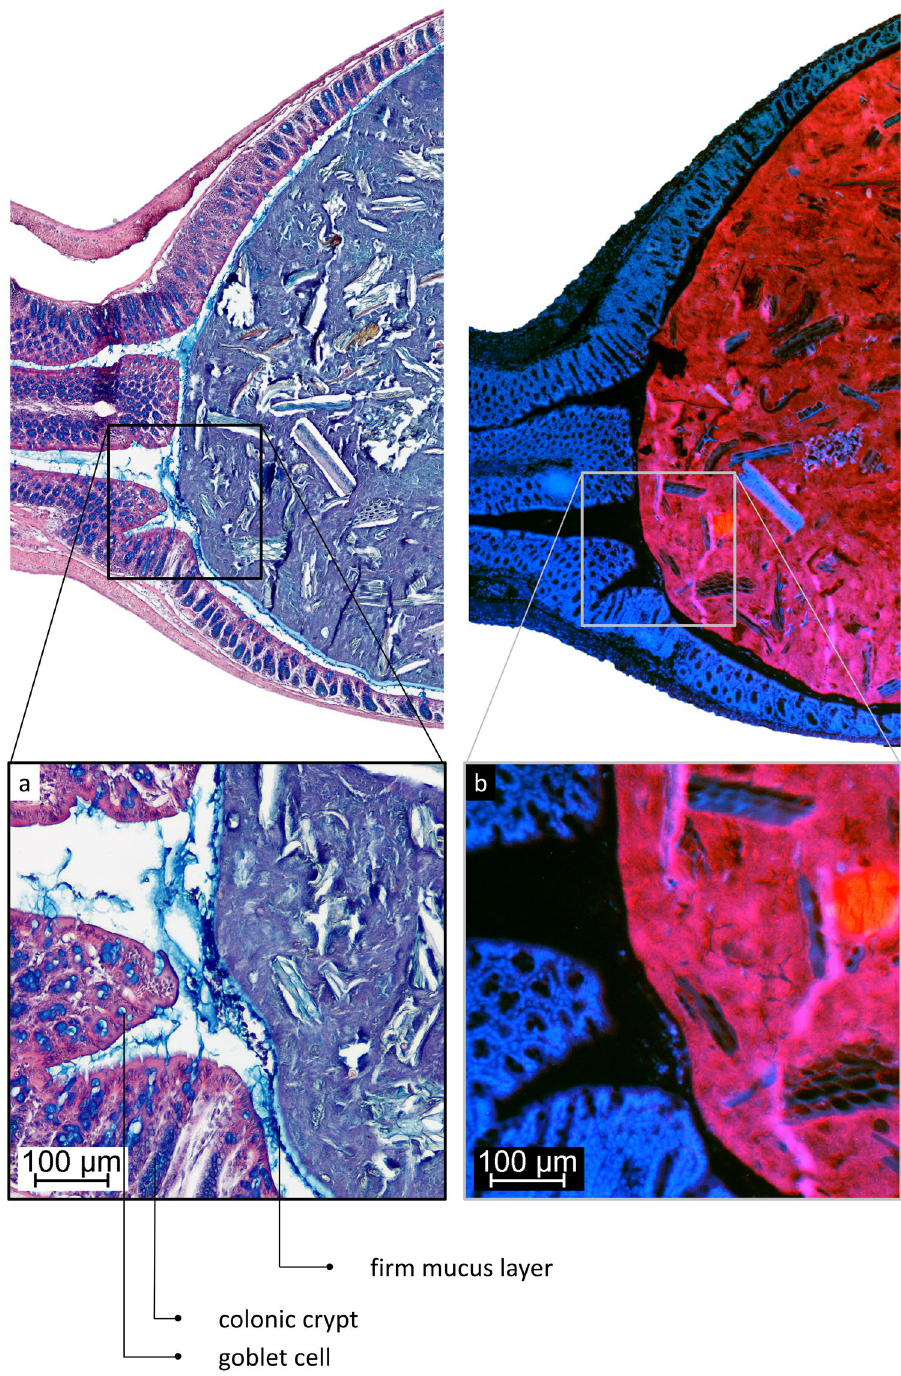
Figure 4. In distal colon, the microbiota is confined to the faecal pellet. ( a ) AB/H/E stained longitudinal section of mouse distal colon. ( b ) FISH stained (Bacteria in red; nuclei in blue) longitudinal section of mouse distal colon. The bacteria are located in the faecal pellet, the lumen of the empty colonic part is almost completely devoid of bacteria, but does contain some loose mucus. A mucus layer devoid of bacteria, confining the bacteria to the faeces, covers the